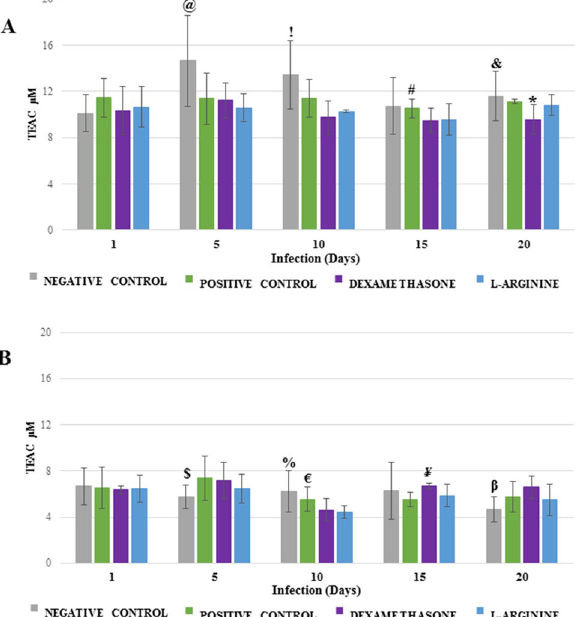
Figure 3. Trolox equivalent antioxidant capacity (TEAC) in the lungs ( A ) and brains ( B ) of Plasmodium berghei -infected Swiss mice. Animals were pretreated and received a daily dose of DEXAMETHASONE, L-ARGININE, or PBS (CONTROL). @ p = 0.0145 versus POSITIVE CONTROL, p = 0.0057 versus DEXAMETHASONE, and p = 0.0009 versus L-ARGININE; ! p = 0.0011 versus DEXAMETHASONE and p = 0.0215 versus L-ARGININE; # p = 0.0401 versus DEXAMETHASONE; & p = 0.0247 versus DEXAMETHASONE; *p = 0.0281 versus L-ARGININE and p = 0.0033 versus POSITIVE CONTROL; $ p = 0.0286 versus POSITIVE CONTROL and p = 0.0273 versus DEXAMETHASONE; % p = 0.0160 versus DEXAMETHASONE; € p = 0.0360 versus L-ARGININE and p = 0.0261 versus DEXAMETHASONE; ¥ p = 0.0357 versus L-ARGININE and p = 0.0005 versus POSITIVE CONTROL; β p = 0.0010 versus